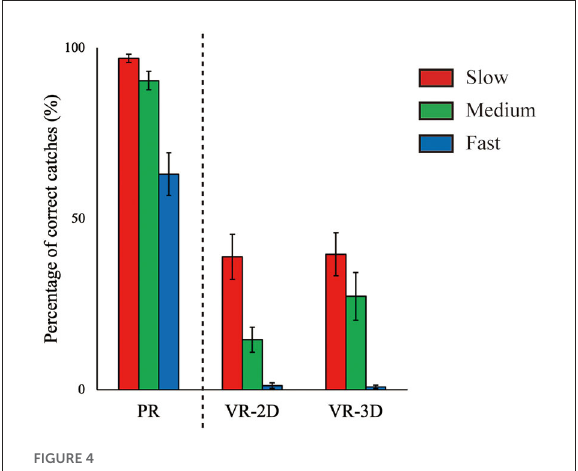
FIGURE4 Mean (error bar: SE) of the percentage of correct catches. The PR condition, shown here for visual comparison with the VR conditions, was excluded in statistical test due to imcomparability in task requirement (see main